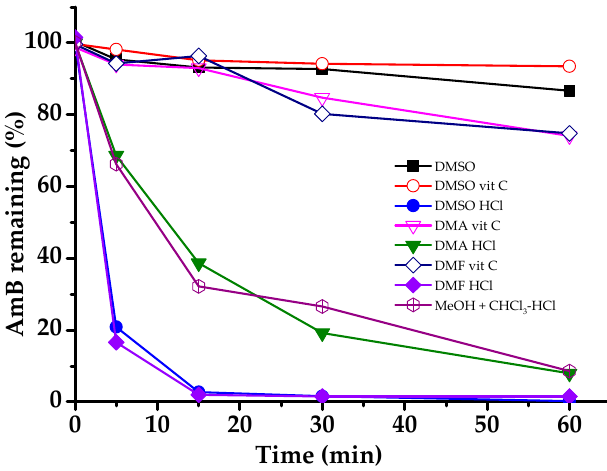
Figure 3. AmB remaining (%) in different organic solvent systems.